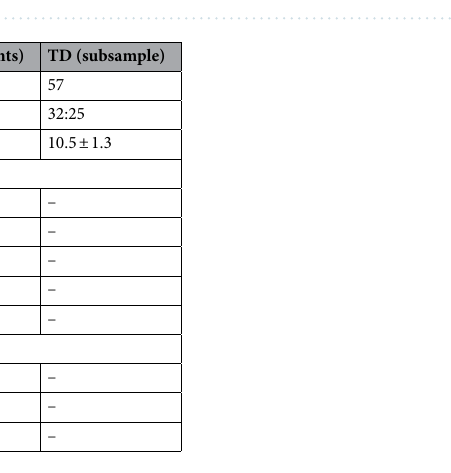
Figure 4. Individual performance of children with DCD on the bimanual object hitting task. Age curves and 95% prediction bands based on performance of all TD participants (n = 155) are shown in blue. Performance scores of each DCD participant (n = 26) are superimposed and shown in red (triangles represent DCD participants without ADHD and circles represent DCD participants with co-occurring ADHD).